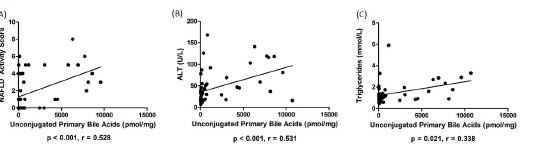
Fig 2. Correlations with fecal unconjugated primary bile acids. (A) Correlation of fecal unconjugated primary bile acids and NAS (p < 0.001, r = 0.528). (B) Correlation of fecal unconjugated primary bile acids and plasma ALT (p < 0.001, r = 0.531). (C) Correlation of fecal unconjugated primary bile acids and serum triglycerides (p = 0.021, r = 0.338).